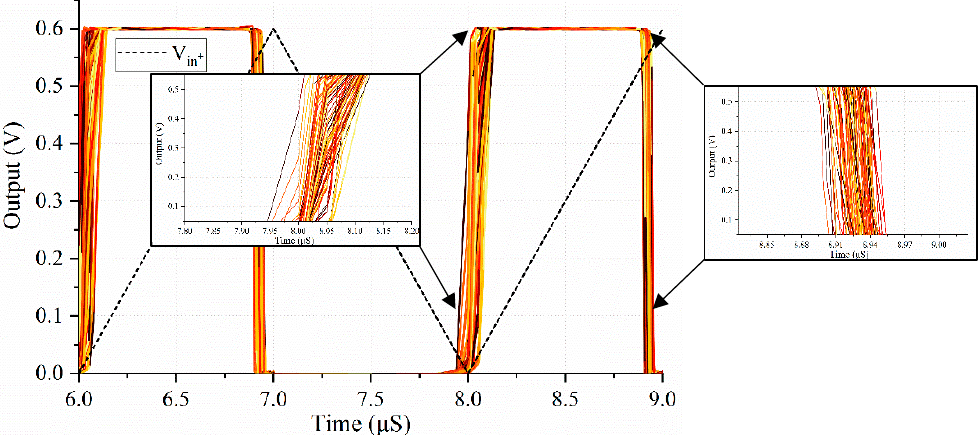
Figure 15. Post-layout simulation for 100 runs of Monte Carlo on the transient response of the input and output voltages.